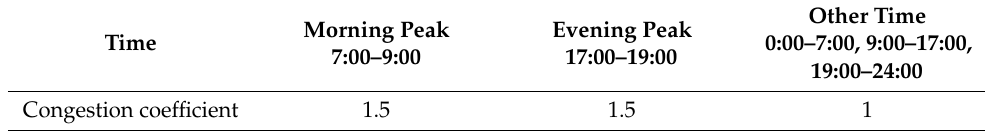
Table 1. Congestion coefficient at different times of